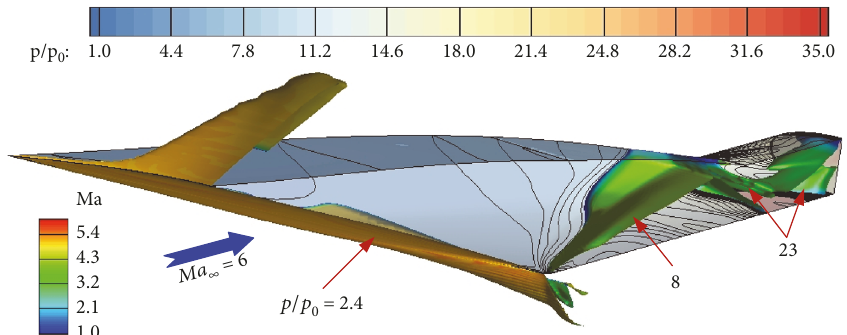
= 6 . The surface wall is contoured by the pressure ratio p/p ∞